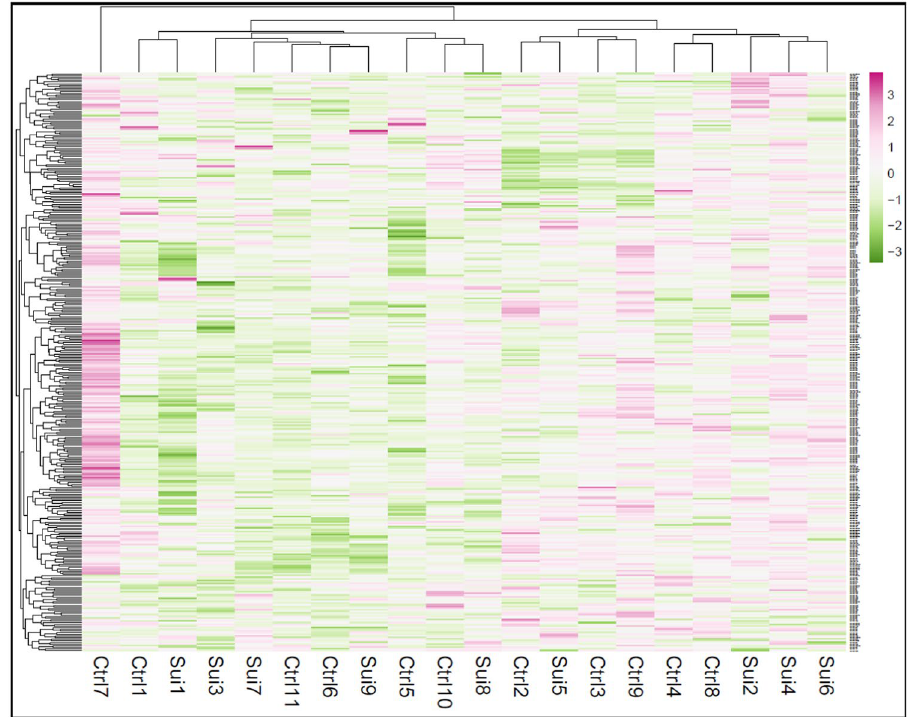
Figure 1. Hierarchical clustering of miRNAs based on median normalized expression data. The construction of dendrogram was based on hierarchical clustering of median normalized miRNA expression data ( ∆ Ct values) in post-mortem locus coeruleus samples which includes both MDD-suicide and healthy control groups. The clustering was prepared following complete linkage method and Euclidean distance. The MDD-suicide group is represented as ‘Sui’ and control is represented as ‘Ctrl’ in this miRNA expression heat map.